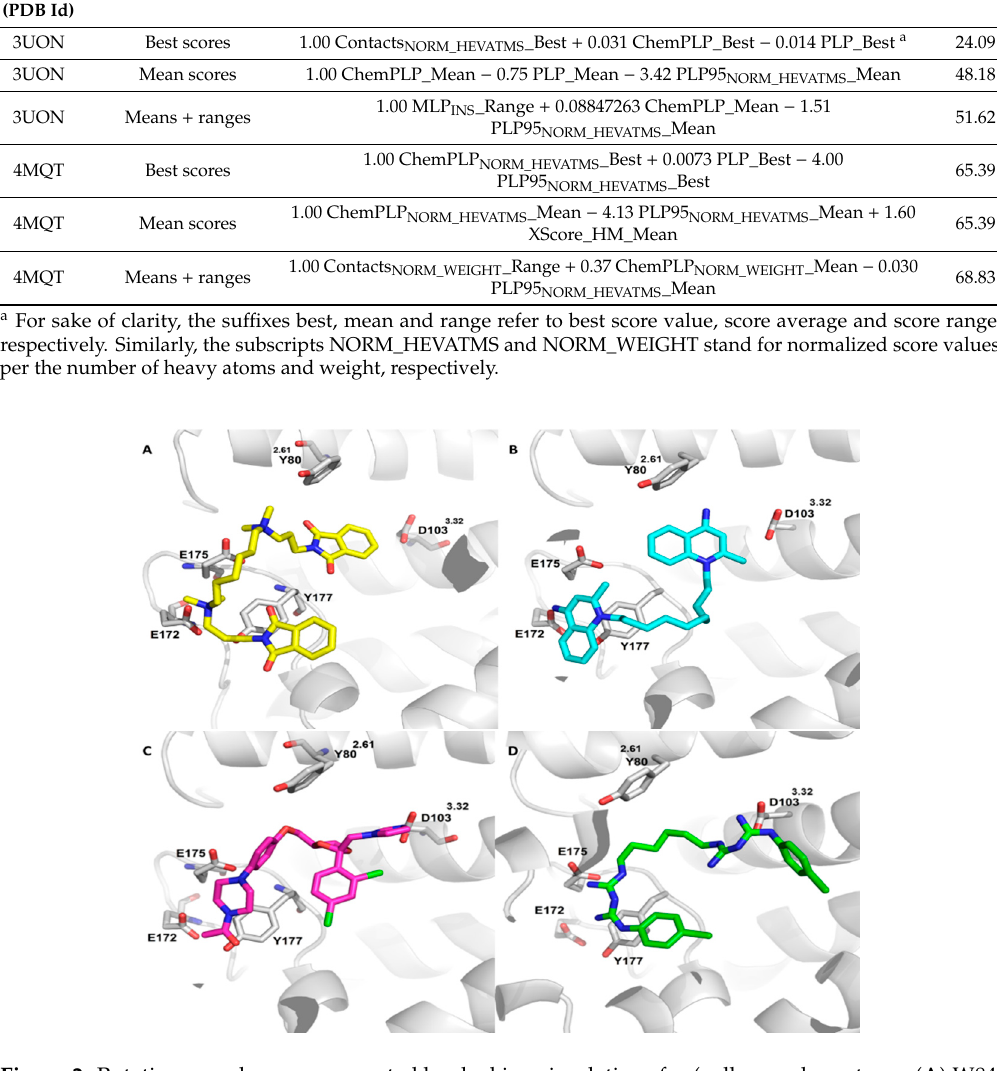
Table 2. Best enrichment factor optimization algorithm (EFO)-based equations as developed by docking simulations on the two considered hM2 structures. Equations based on the combination of the two proteins were omitted because they were identical to those produced by 4MQT only. (a) For sake of clarity, the suffixes best, mean and range refer to best score value, score average and score range, respectively. Similarly, the subscripts NORM_HEVATMS and NORM_WEIGHT stand for normalized score values per the number of heavy atoms and weight, respectively.